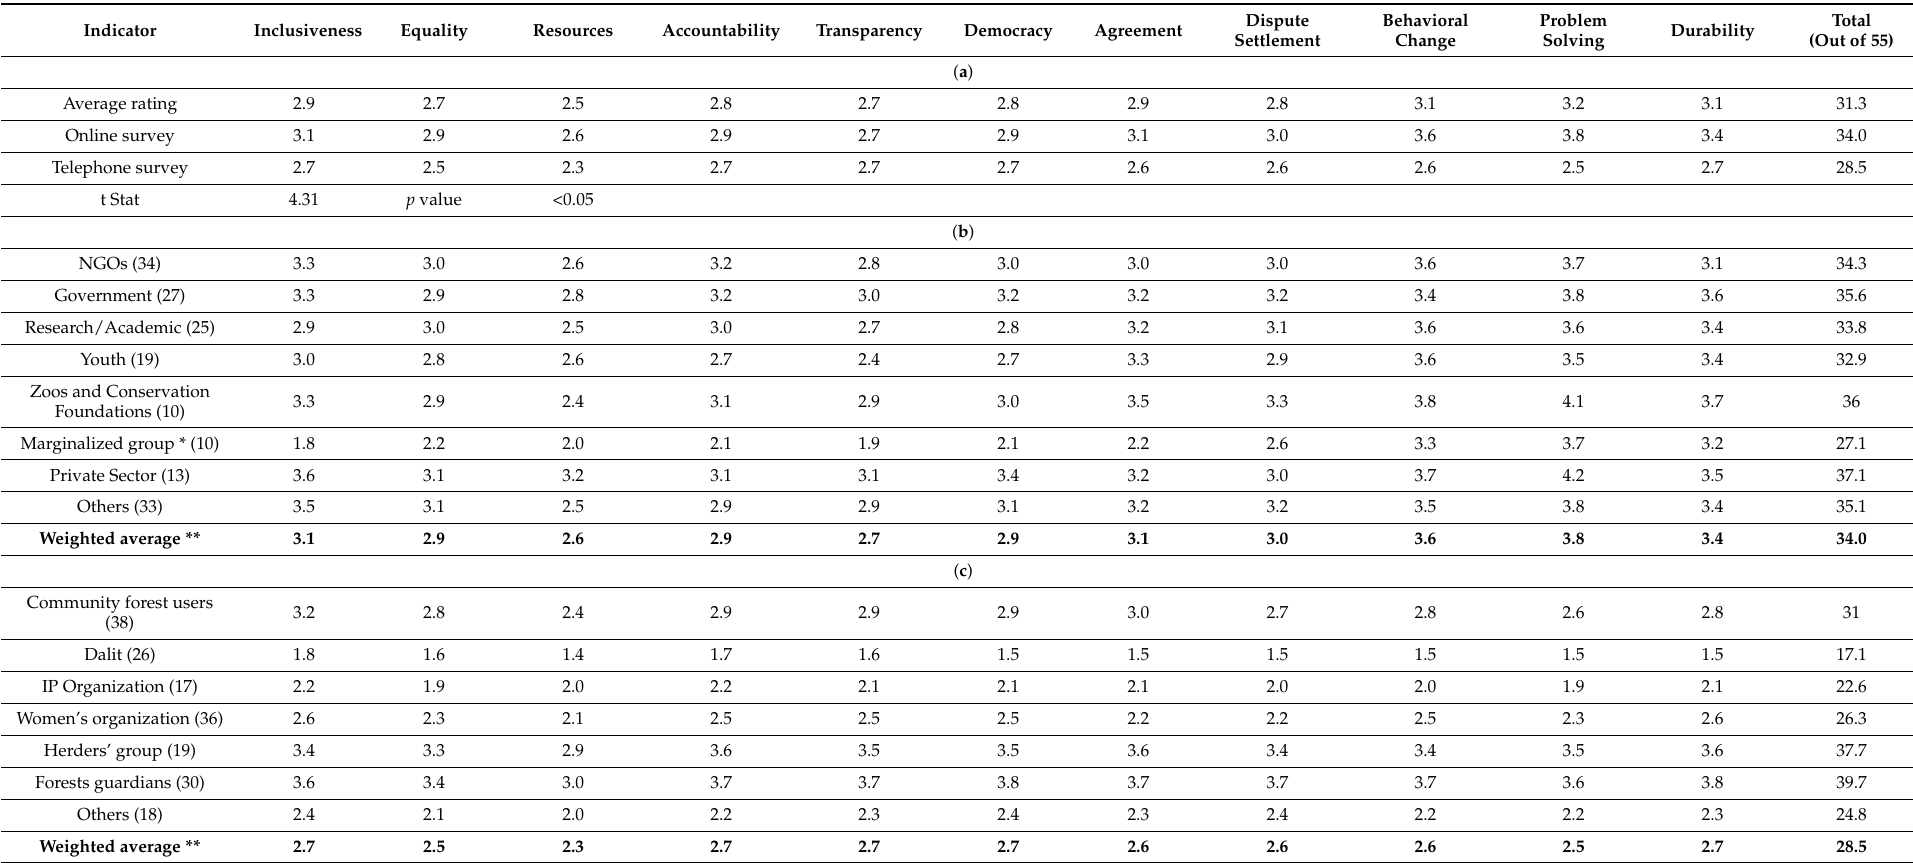
Table 4. ( a ): Overall, online and telephone survey details of respondents’ perceptions on the quality of forest governance in Nepal. ( b ): Online survey of respondents’ perceptions on the quality of forest governance in Nepal. ( c ): Telephone survey of respondents’ perceptions on the quality of forest governance in